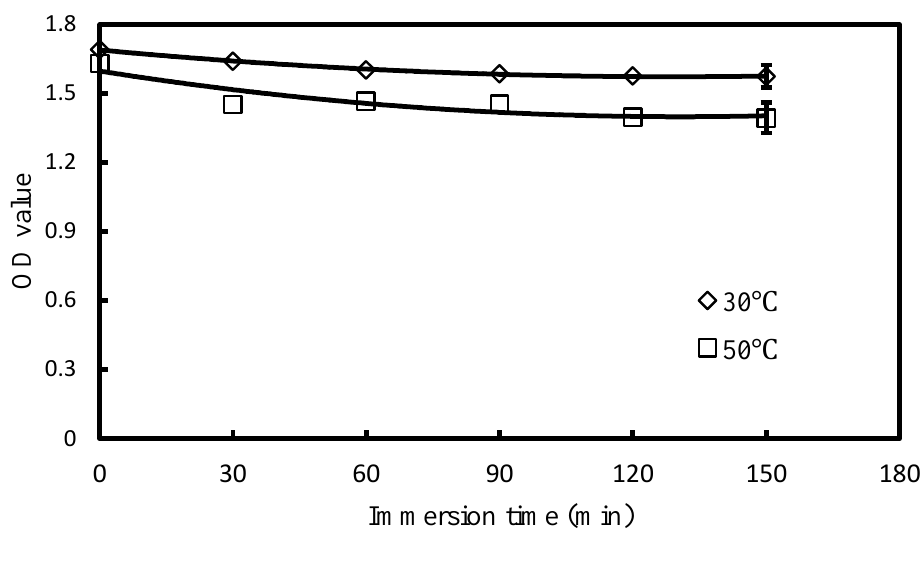
Figure 2. Variations in the optical density (OD) value of the microalgae biomass at different immersion times in a 0.54 M KCl solution at 30 °C and 50